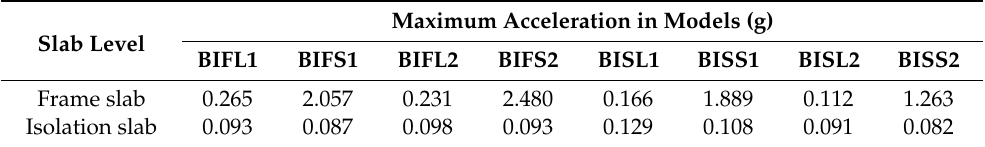
Table 6. Without-pounding